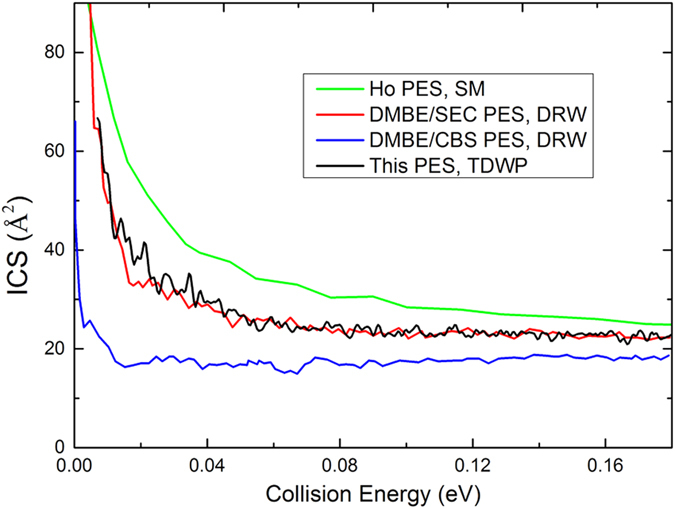
The total ICS of the S(1D) + H2(X1Σg+) → H(2S) + SH(X2Π) reaction calculated by the TDWP method.Also included are the theoretical results21 from SM calculations employing the Ho PES and the theoretical results20 obtained from the DRW code on DMBE/SEC PES and DMBE/CBS PES.